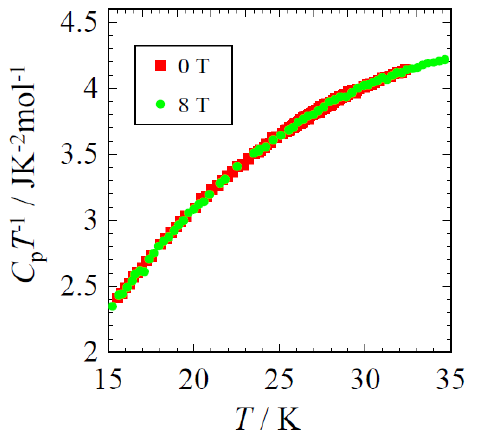
Figure 4. C T −1 vs . T plot of κ -(BEDT-TTF) p temperature obtained under 0 T and 8